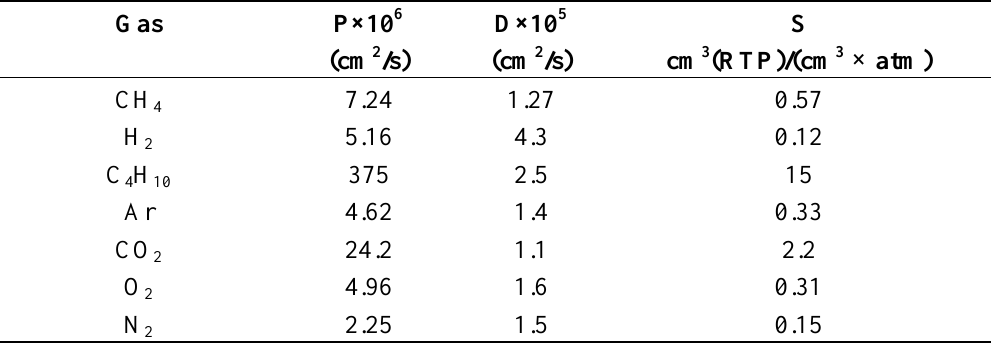
Table 1. PDMS material parameters for the computational